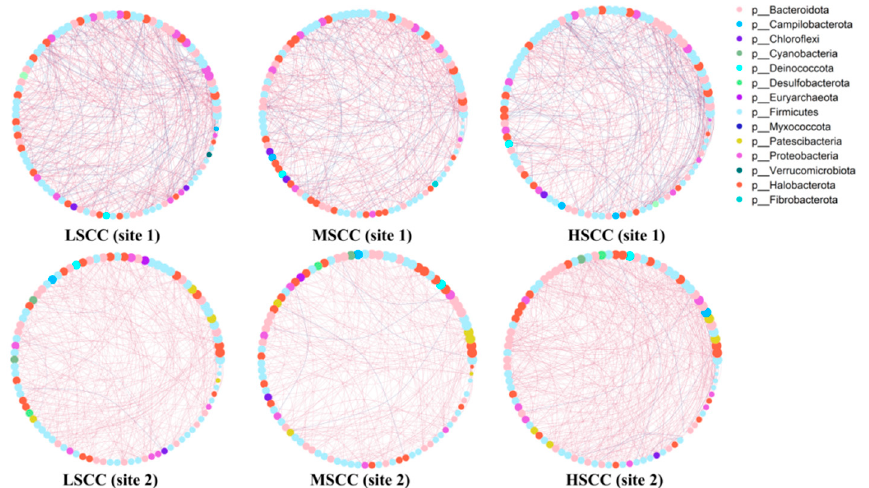
Figure 5. Co-occurrence networks of the top 100 predominant bacteria in different groups (spearman correlation > 0.8). Each node represents one genus. The size of the node represents mean relative abundance in the corresponding group. Red edges represent positive correlation and blue edges represent negative correlation. Table 2. Kolmogorov–Smirnov test of each microbial network topological parameter in two sites. Comparison Degree Betweenness Centrality Closeness Centrality Transitivity LSCC vs. HSCC